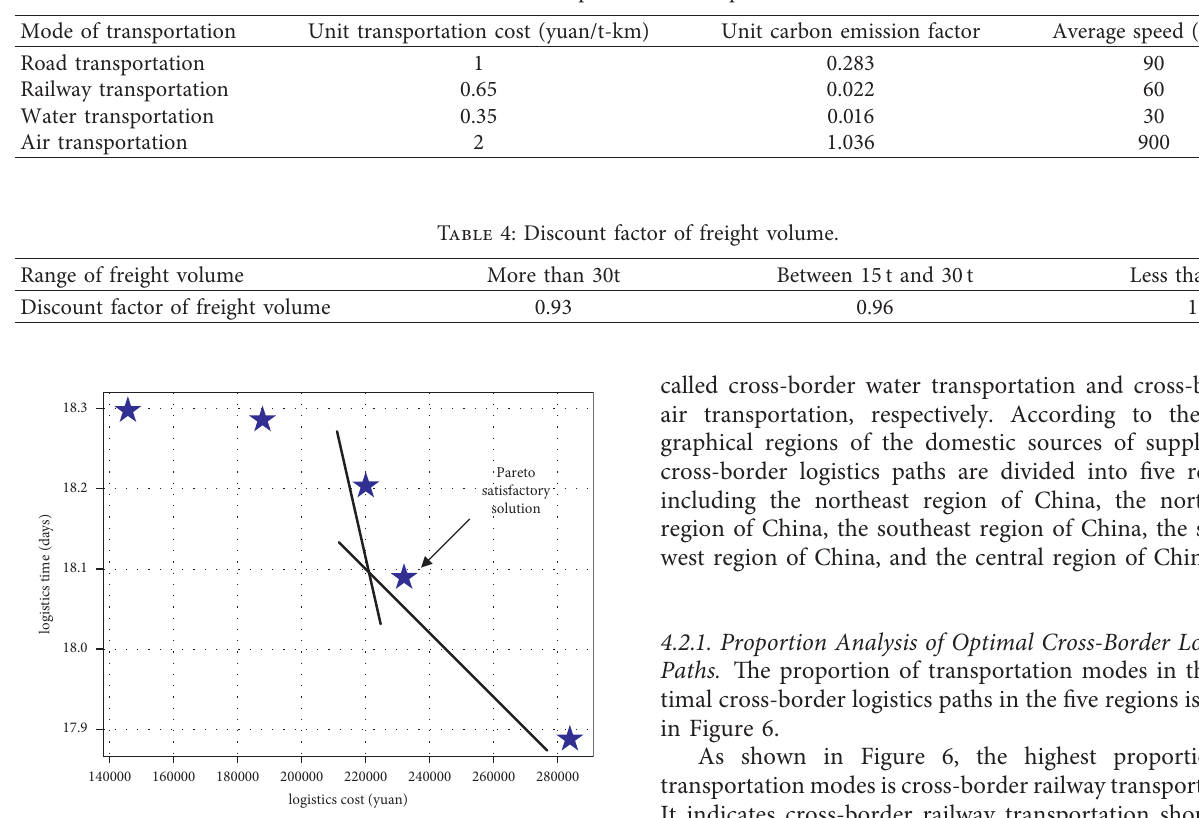
Table 3: Transportation mode parameters.